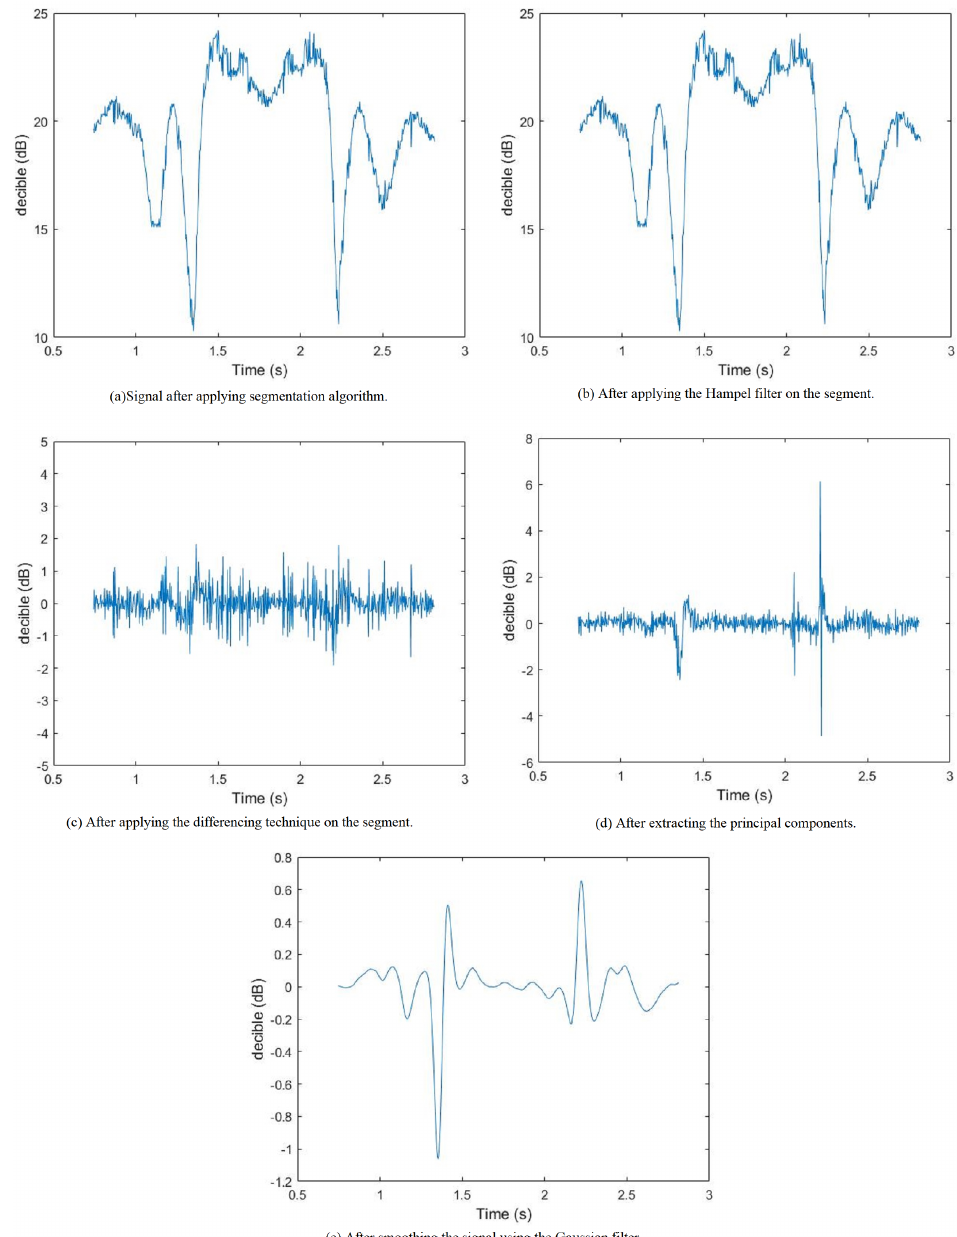
Figure 16. The output of each of the signal processing